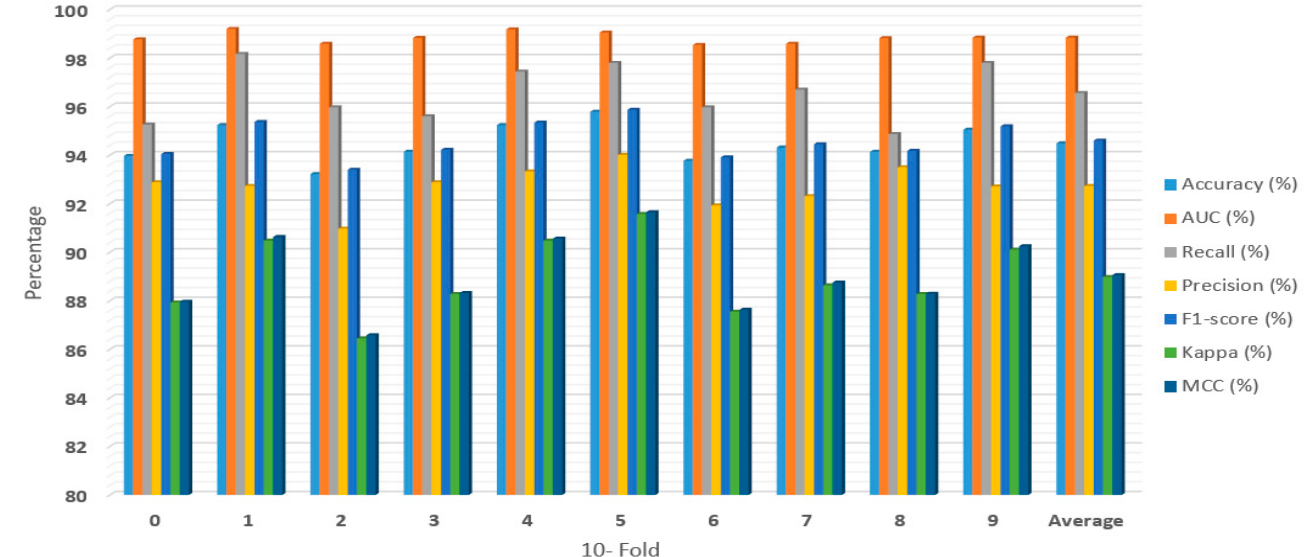
Figure 2. The metrics of the RF model before hyper-parameters tuning.